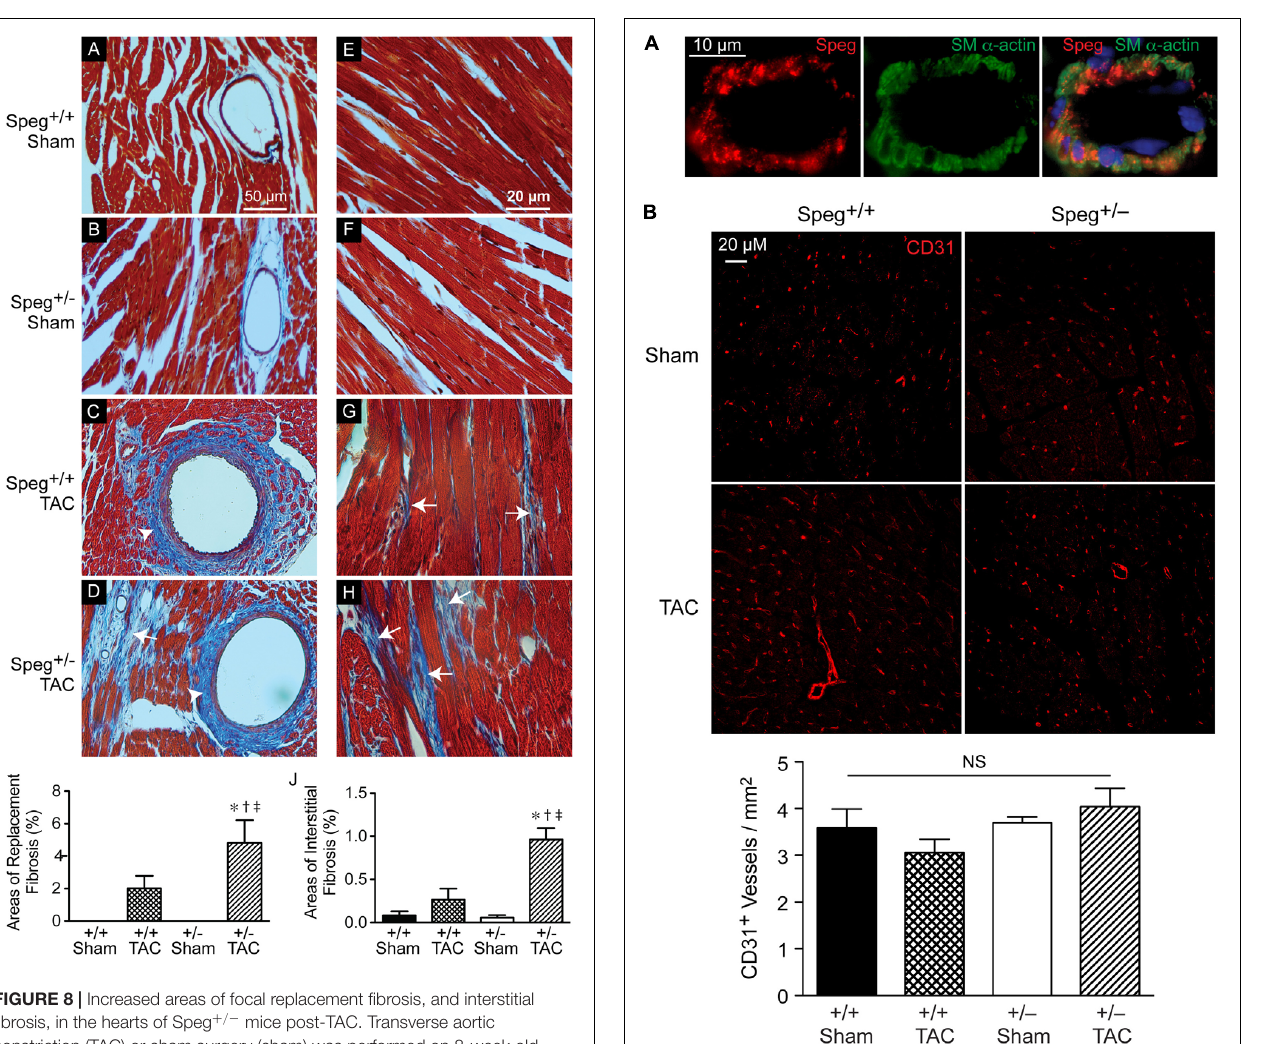
FIGURE 9 | Speg is present in cardiac vessels of adult mouse hearts, and there is no difference in the number of vessels between Speg + / + and Speg + / − hearts at baseline or after TAC. (A) Representative image of fluorescent microscopy for Speg (red, left panel) and smooth muscle alpha-actin (SM α -actin, green, middle panel) staining of vascular smooth muscle cells from a vessel of an adult mouse heart. The vessels were also co-stained with 4 (cid:48) ,6-diamidino-2-phenylindole (DAPI, blue) to identify nuclei (merged image, right panel). Scale bar, 10 µ m. (B) Representative images of fluorescent microscopy for CD31 (red) staining of vessels from the left ventricles of Speg + / + and Speg + / − hearts, 4 weeks after sham or TAC surgery (upper panels). The lower panel (bar graph) shows quantification of CD31 + vessels per mm 2 of tissue (sham, n = 4/group; TAC, n = 5/group). Analysis by one-way ANOVA ( P = 0.277). NS, not